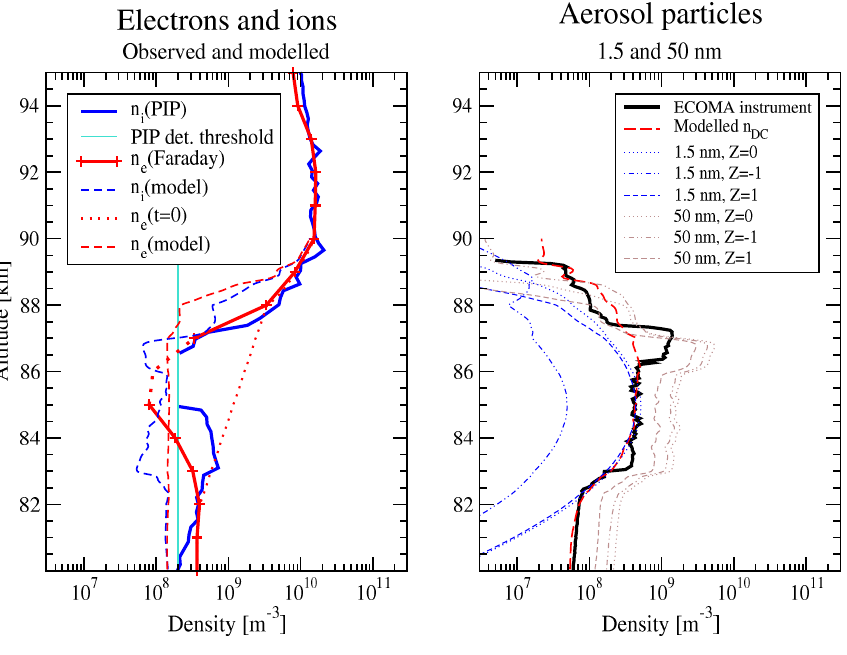
Fig. 6. The same model as in Fig. 5, except that we have added “smoke” particles with r a = 1 . 5nm, a Gaussian altitude distribution with a peak density of 10 9 m − 3 at 85km, and a smoke particle photoionisation rate I a = 10 − 2 s − 1 .